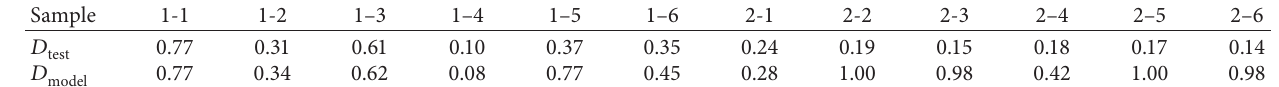
Table 2: The final damage value of the test curve and model